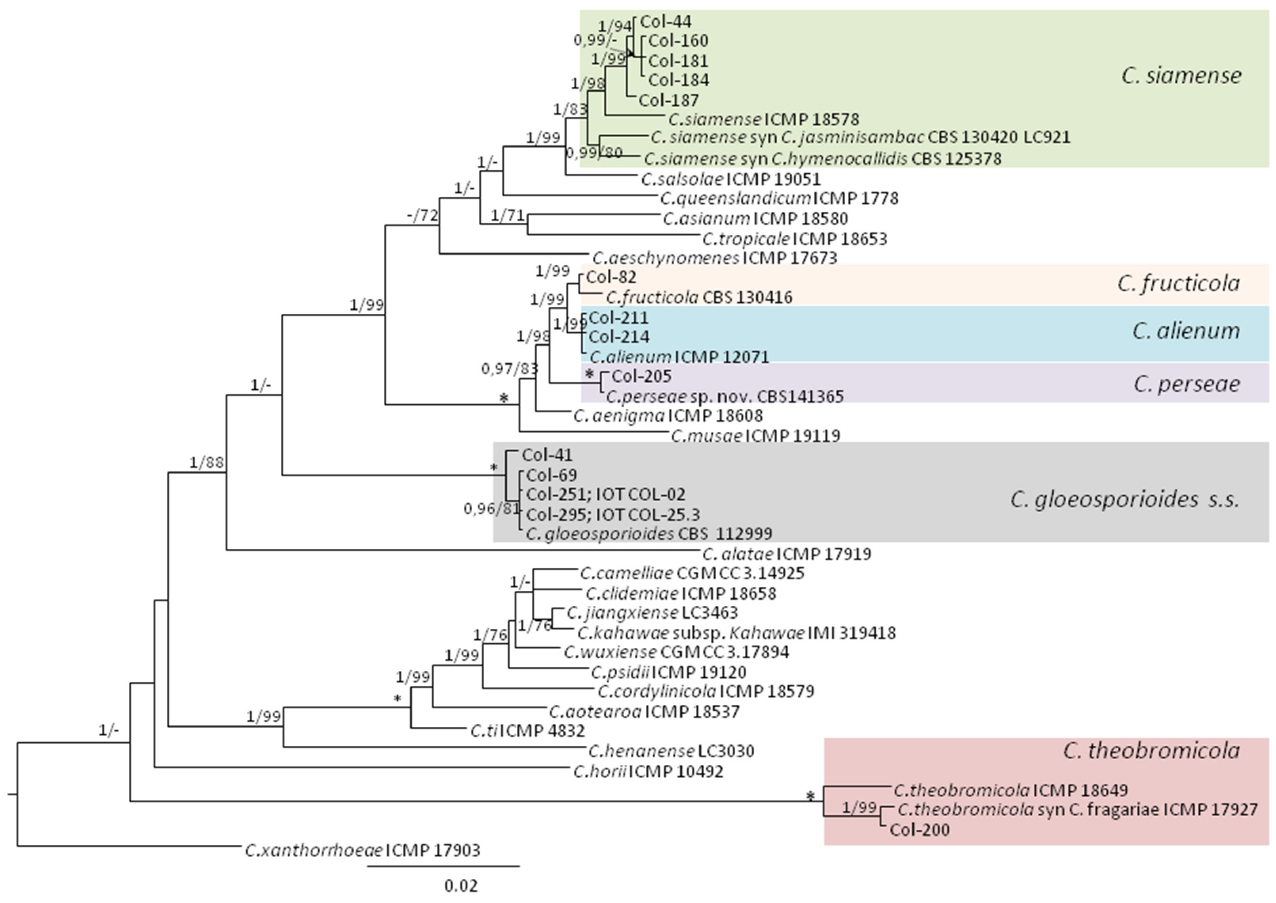
Figure 5. Phylogenetic tree obtained by Bayesian analysis using the combined ITS, TUB2, and ApMat sequence alignments of the Colletotrichum gloeosporioides species complex. Bayesian posterior probabilities (PP, > 0.9) and bootstrap support values (MP, (BS) > 70%) of Maximum Parsimony analysis are shown in the nodes (PP/MP). The asterisk (*) indicates full support (1/100). Colletotrichum xanthorrhoeae (ICMP 17903) was used as outgroup.